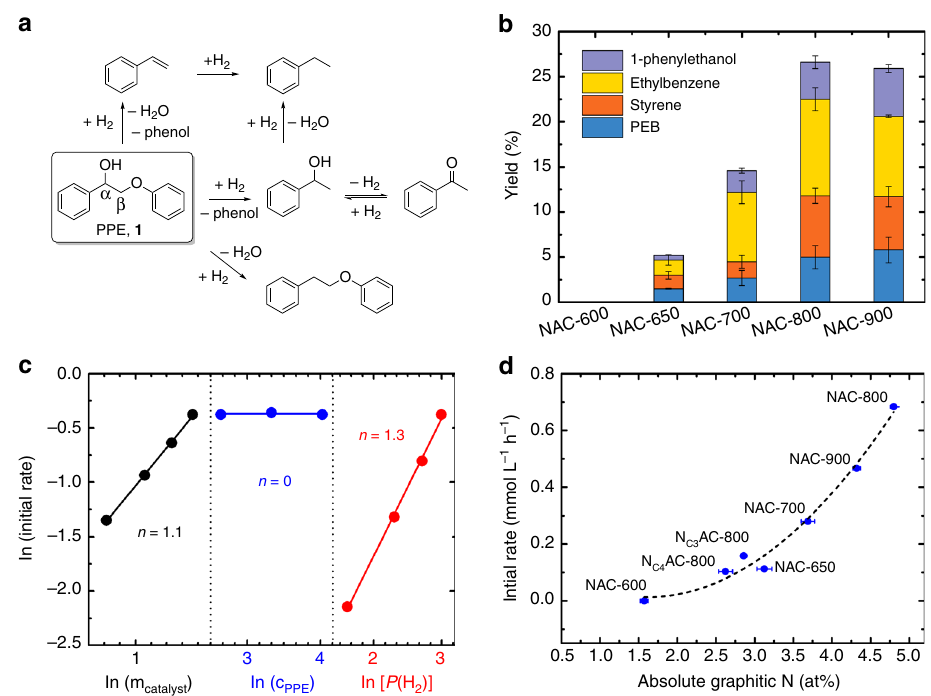
Fig. 2 Activity results for PPE hydrogenation over the NAC catalysts at 230 °C. a Reaction network. b Yields of products (except phenol). The PPE conversions and yields for 1-phenylethanol (purple), ethylbenzene (yellow), styrene (orange), and PEB (blue) are shown in Supplementary Table 5. Reaction conditions: 14-mmolL − 1 PPE in 2-PrOH (1.50 mL), NAC catalyst (5.0 mg), 20-bar H 2 , 8 h. The error bars are standard deviation (s.d.) of repeated tests. c Measurement of rate orders for the NAC-800 catalyst (black), PPE (blue), and H 2 (red). d Plots of initial rates of PPE conversion against the absolute amount of graphitic N in NAC catalysts. The error bars of absolute content of graphitic N were estimated and given in Supplementary Table 3 and the s.d. of the initial rates are ~3% of the mean values, obtained after repeated